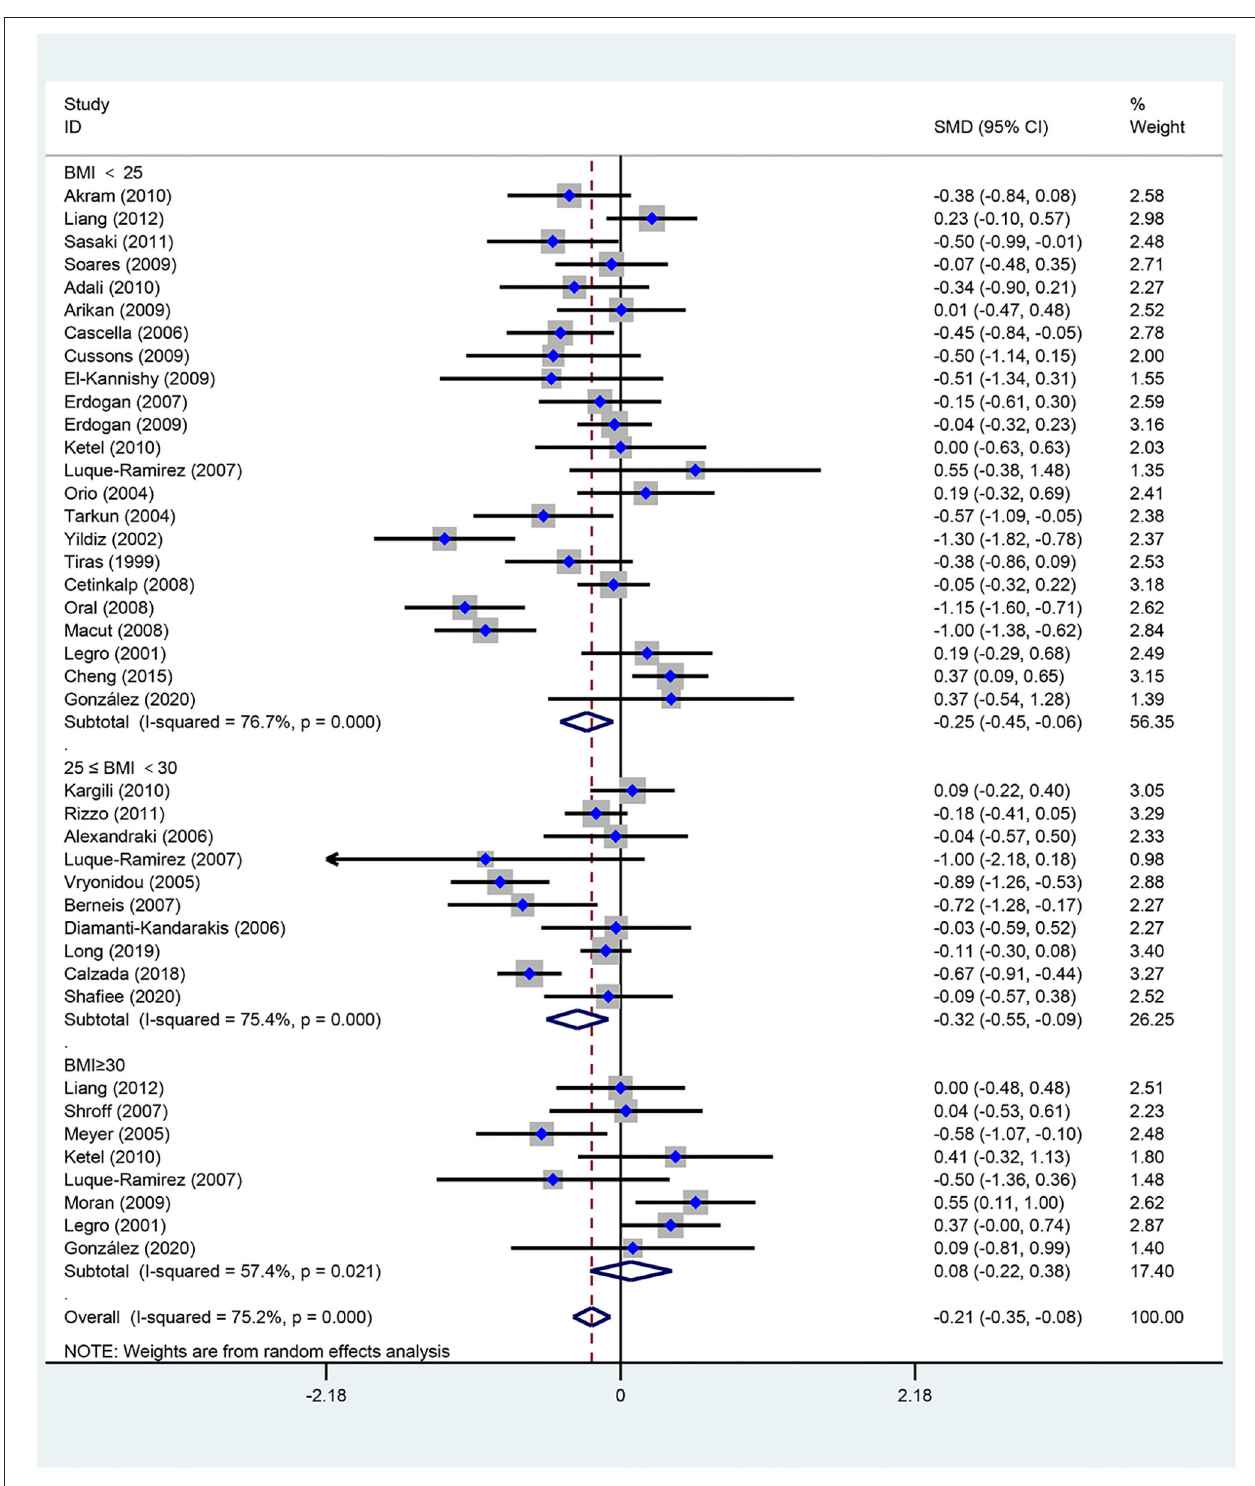
FIGURE 2 | Forest plot for comparison of high-density lipoprotein-cholesterol in subjects with polycystic ovary syndrome (PCOS) vs. control subjects. Studies are classified by different body mass index (BMI) categories (BMI < 25 kg/m 2 , BMI ≥ 30 kg/m 2 , and BMI 25–30 kg/m 2 ).